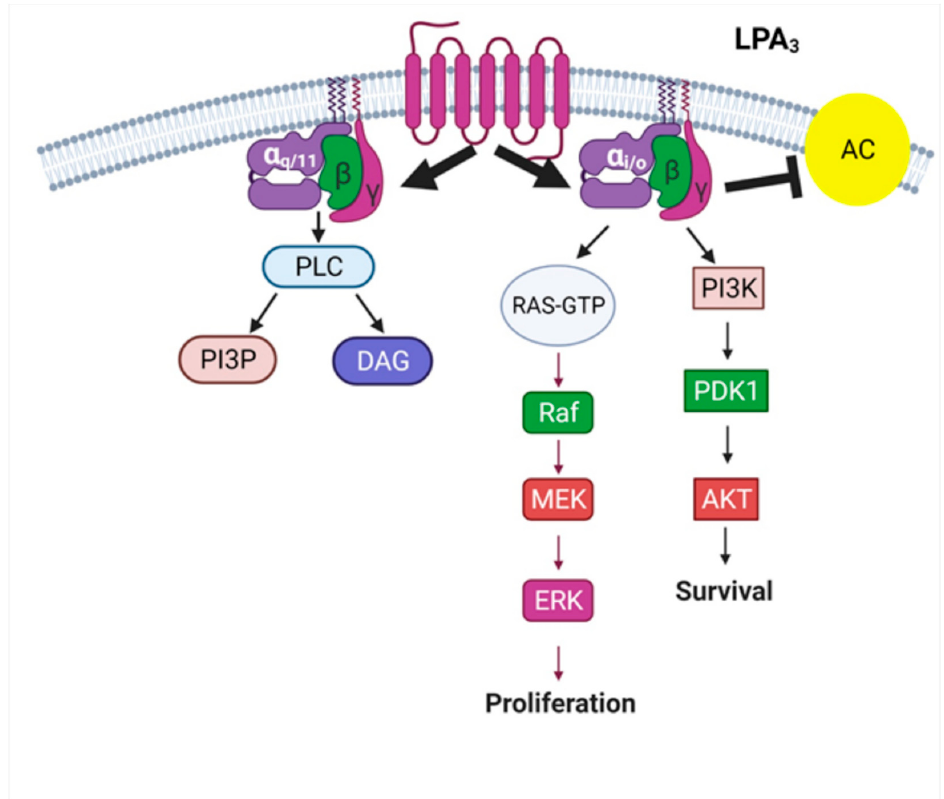
Figure 4. Signaling pathway of LPA 3 receptors. Activation of this receptor subtype with LPA promotes conformational changes favoring intense interaction with G α q/11 and G α i/o, which lead to activation of downstream signaling molecular entities. Abbreviations as in Figure 2. Created with BioRender.